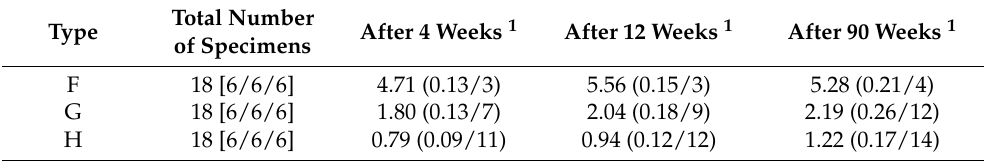
Table 3. Mortar compressive strength f m in MPa.